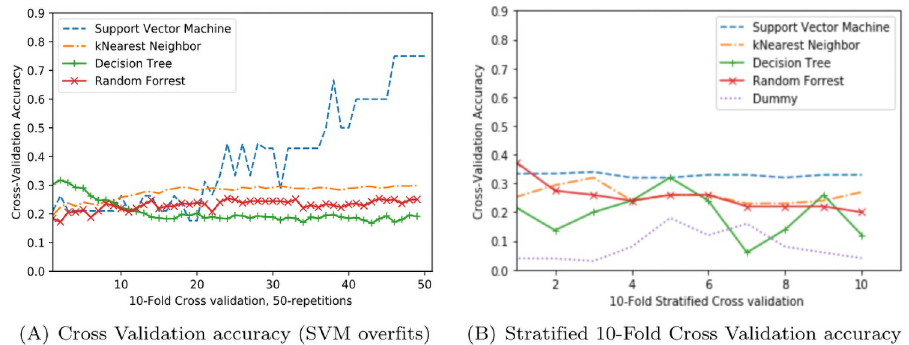
Fig 5. Accuracy comparison for node assignments to 29-clusters incorporating metadata. A. Cross validation, B. Stratified Cross Validation.